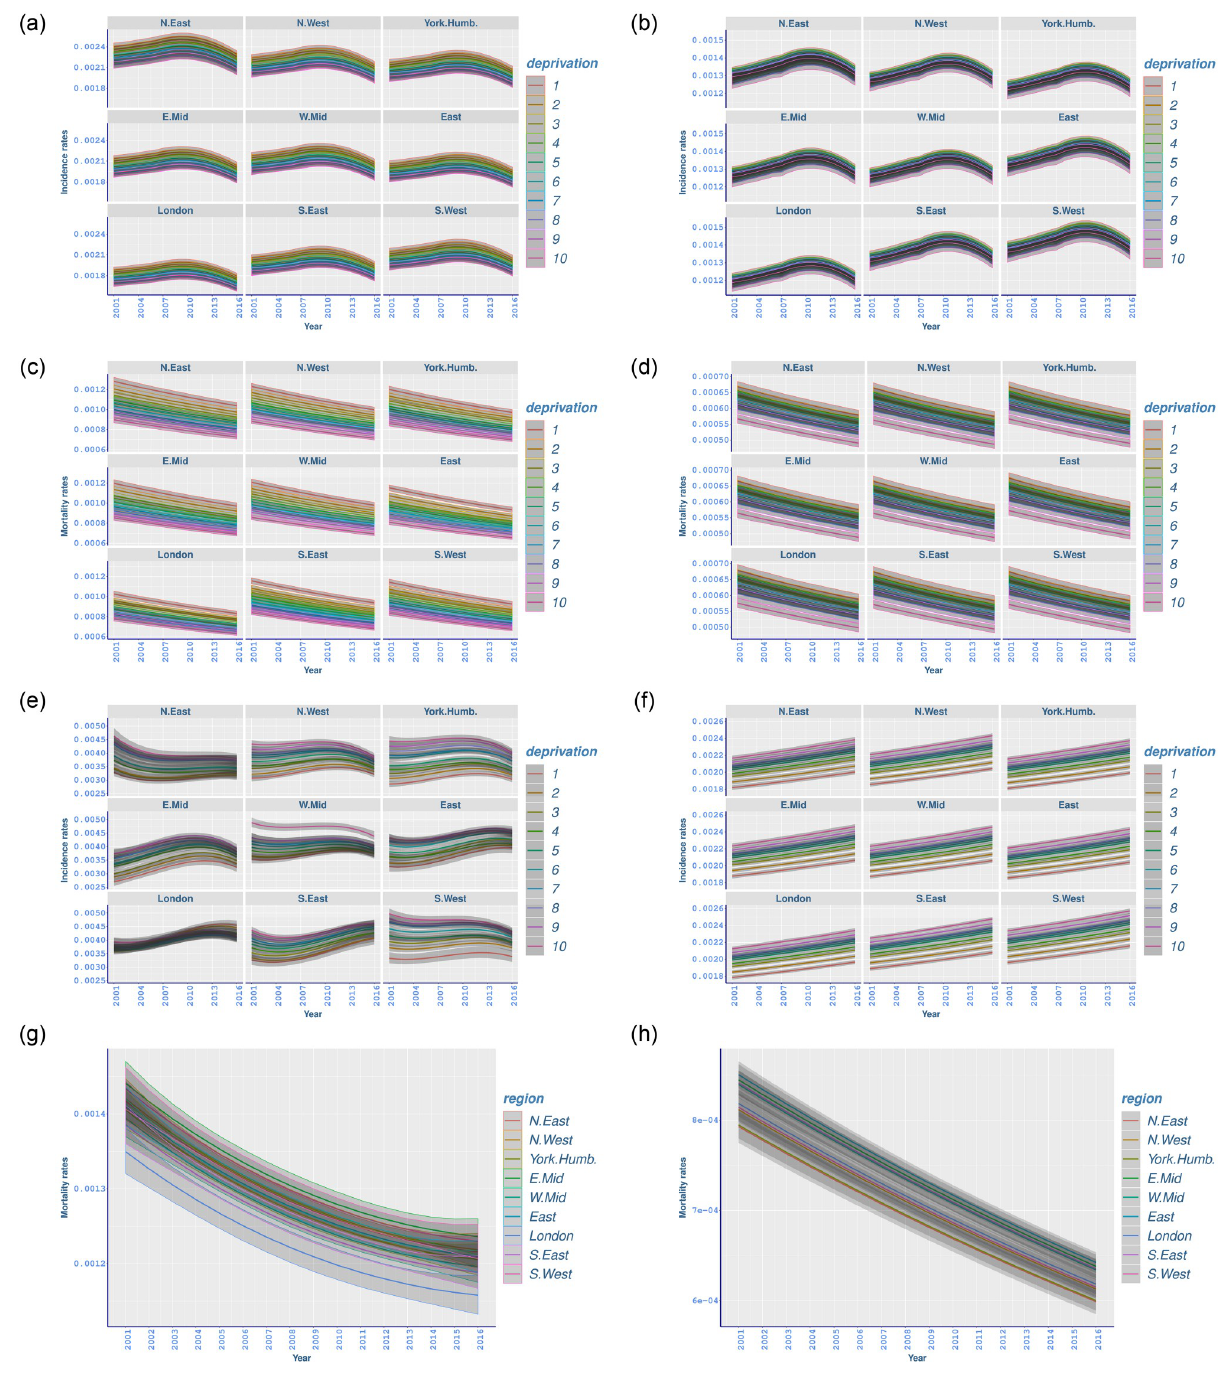
Fig 2. Age-standardised fitted incidence and mortality rates (with 95% credible intervals) for bowel, prostate, and breast cancer, between 2001 and 2016 for different deprivation deciles and regions in England. (a) Male bowel cancer incidence; (b) Female bowel cancer incidence; (c) Male bowel cancer mortality; (d) Female bowel cancer mortality; (e) Prostate cancer incidence; (f) Breast cancer incidence; (g) Prostate cancer mortality; (h) Breast cancer mortality.